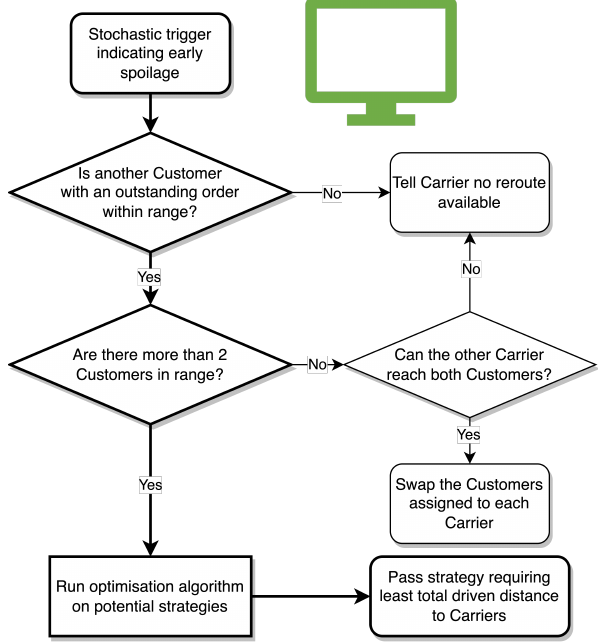
Figure 7. The logic followed by the